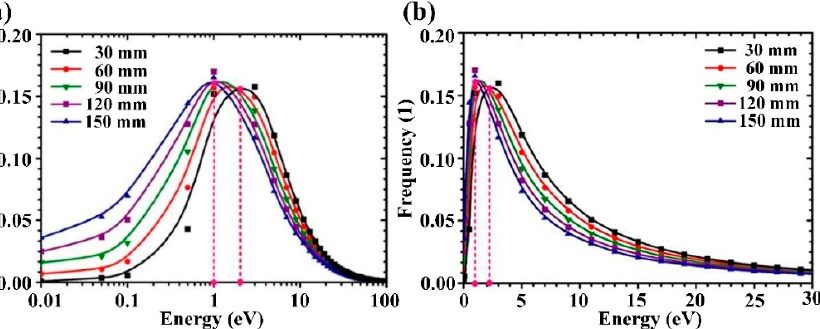
Figure 10. Incident energy distribution of the deposited sputtered Cu atoms at different target-sub- strate distances plotted on ( a ) logarithmic scale and ( b ) linear scale. substrate distances plotted on ( a ) logarithmic scale and ( b ) linear